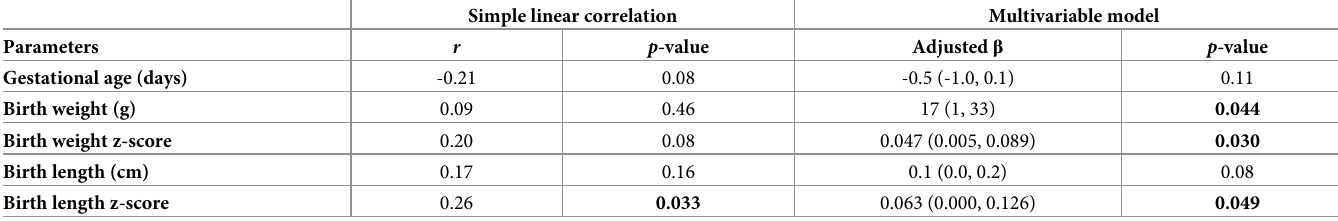
outcomes. LINE-1 partial methylation (uCmC) levels were associated with higher diastolic blood pressure (+2.4 mmHg for every 10% increase; p = 0.025) (S2 Table). Alu partial methyla- tion (uCmC) levels were associated with higher cholesterol levels (20.6 mg/dl for every 10% increase; p = 0.015) but Alu hypomethylation (uCuC) levels with lower cholesterol levels (-13.6 mg/dl for every 10% increase; p = 0.030) (S3 Table). Table 3. Linear associations between maternal plasma zinc concentrations in late pregnancy and offspring characteristics at